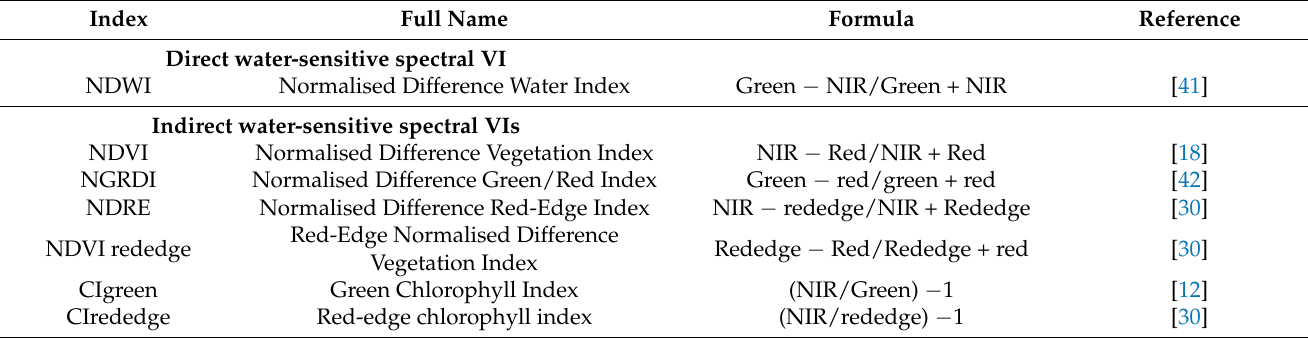
Table 3. List of vegetation indices (VIs) used in the modelling of crop water content and related source